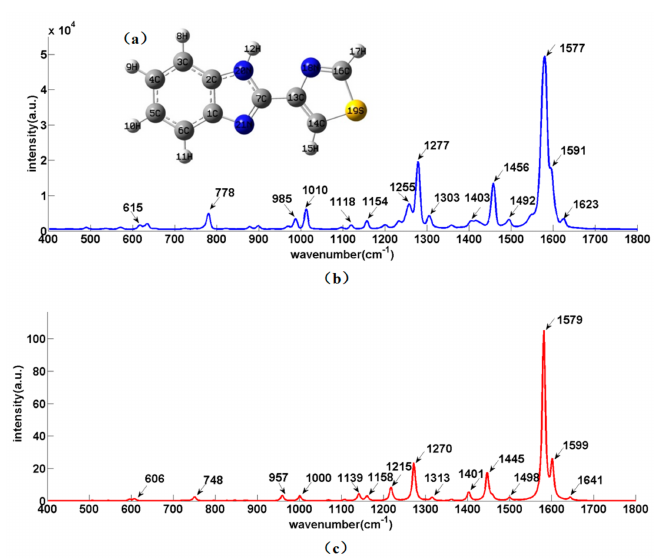
Figure 1. The molecular structure of thiabendazole and its positions of functional groups vibration. ( a ) The molecular structure of thiabendazole; ( b ) Raman Spectroscopy (RS) of thiabendazole solid; ( c ) the thiabendazole RS simulated by density functional theory (DFT).